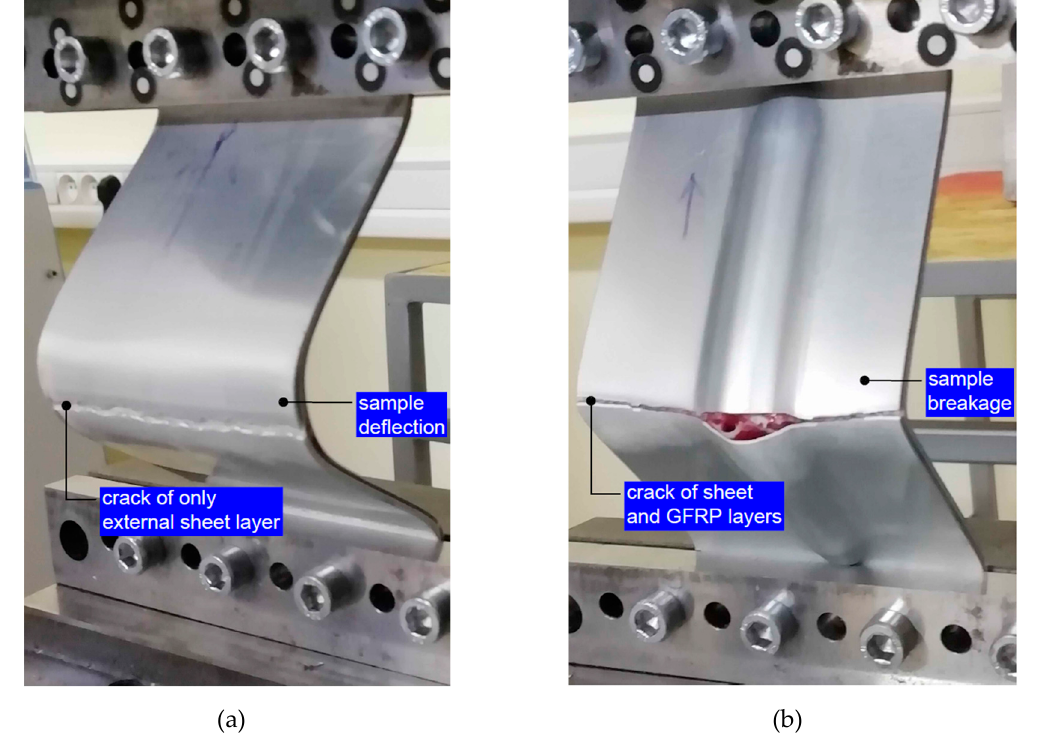
Figure 25. View of the ( a ) FML panel and ( b ) GLARE-based rib-stiffened panel after the compression test.